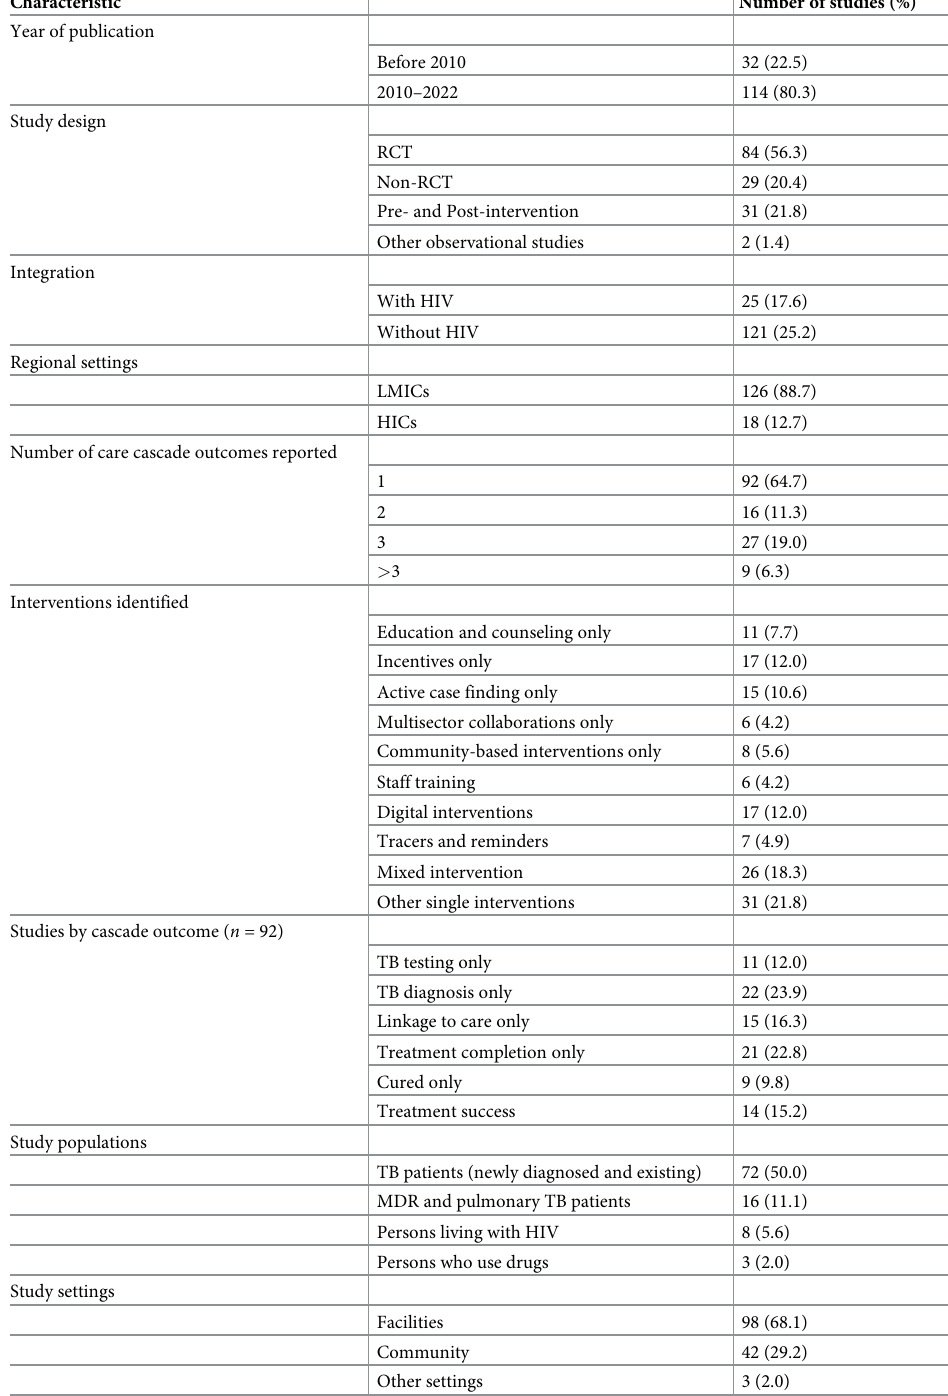
Table 3. Summary showing characteristics of all eligible studies included in this review (N =